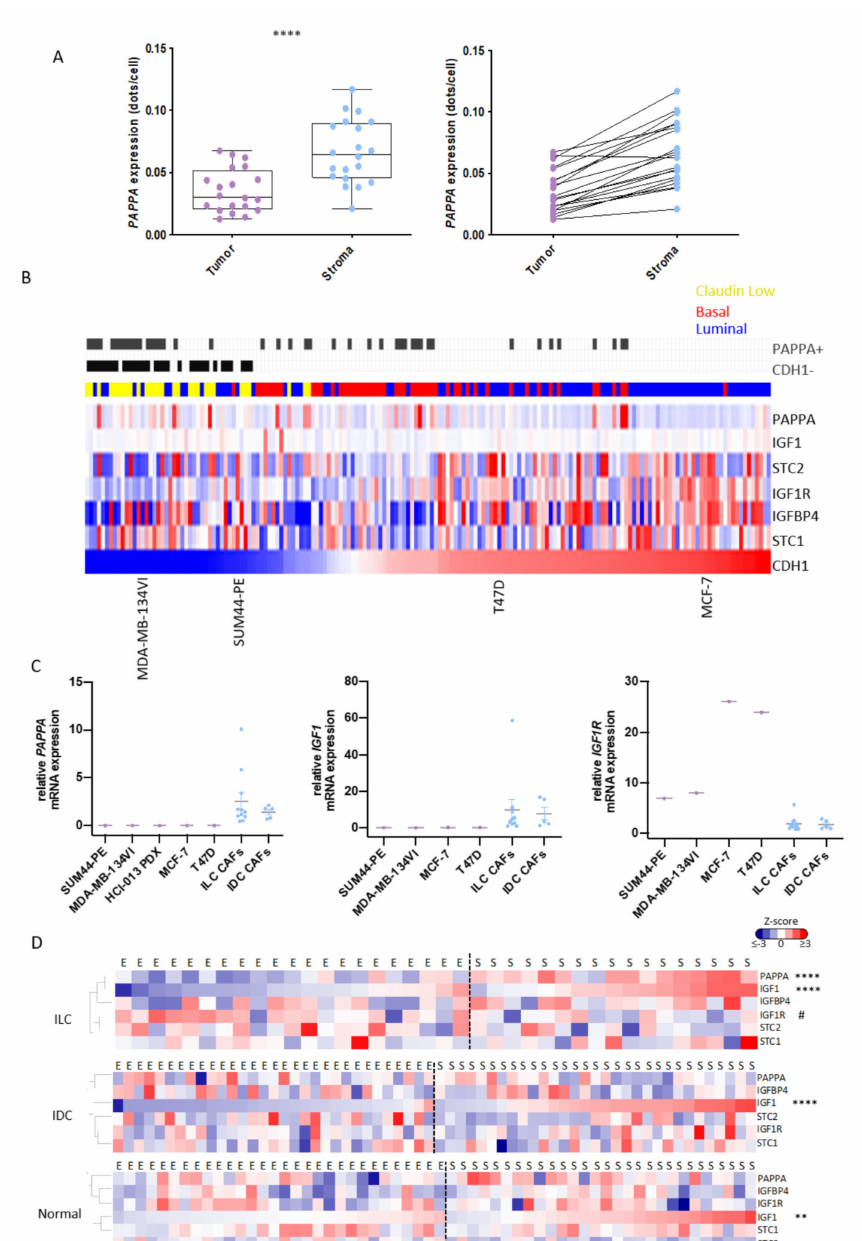
Figure 5. PAPPA and IGF1 are predominantly expressed in the stroma of ILC. ( A ) RNAScope for PAPPA was performed in 20 ILC tumor samples that were used for generation of the LCM-ILC dataset. Samples were analyzed using QuPath with transcripts in both the stromal and epithelial compartments quantified. Left: Boxplots representing expression of PAPPA (dots per cell) in the tumor and stroma. Paired t -test, **** p < 0.0001. Right: Trend lines show an increase in PAPPA in the stroma of ILC samples compared to the tumor cells. Purple and blue dots represent data from tumor epithelium and stroma, respectively. ( B ) Heatmap representing the expression of PAPPA and associated genes across three integrated panels of breast cancer cell lines following batch correction, ranked by CDH1 expression. Blue, luminal; red, basal; yellow, claudin-low. Grey bars indicate samples where the detection call for PAPPA is assigned as ‘present’ and those tumors where CDH1 is ‘absent’. ( C ) Expression of PAPPA , IGF1 and IGF1R by qPCR in ILC human cell lines (purple dots)